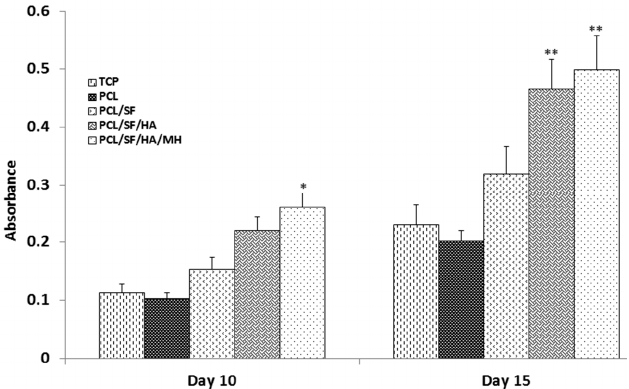
Figure 11. Quantification of mineral deposition in MSCs differentiated into osteogenesis. Alizarin Red-S staining on TCP, PCL, PCL/SF, PCL/SF/HA and PCL/SF/HA/MH micro/nanoparticles. * p ≤ 0.05, ** p ≤ 0.001.